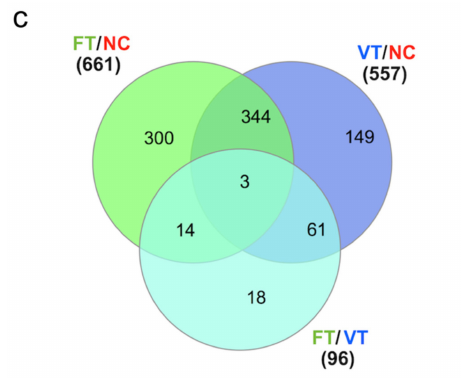
Figure 5. Identification of ART-associated metabolomic and gene expression in prepuberal o ff spring. ( a ) Principal components analysis and ( b ) Heat-Maps of all di ff erential untargeted metabolites in the liver of o ff spring born after the embryo manipulation during the transfer procedure (FT, green) or vitrified embryos procedure (VT, blue) compared to nonmanipulated (NC, red). Each is individual plotted. ( c ) Venn diagram showing the overlap among the metabolites altered by the FT vs. NC, VT vs. NC and FT vs. VT for the analysis focused on embryo manipulation.